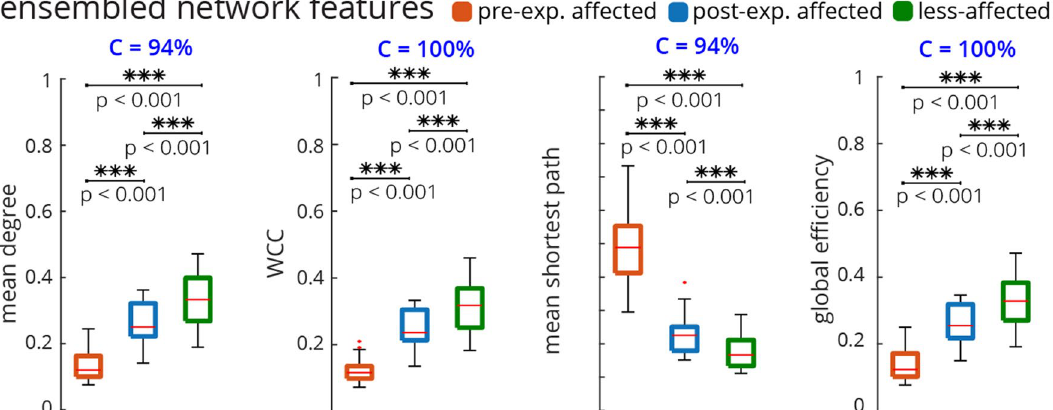
Figure 7. The ensembled metrics of the mutual information network across all n = 32 subjects. For each subject, the median muscle network across all trials was computed. Then, the four metrics shown were computed for this ensembled network. All network metrics monotonically changed from pre-exposure affected to post-exposure affected and less-affected limbs. The mean WCC and global efficiency had perfect conformity, C = 100%. WCC: weighted clustering